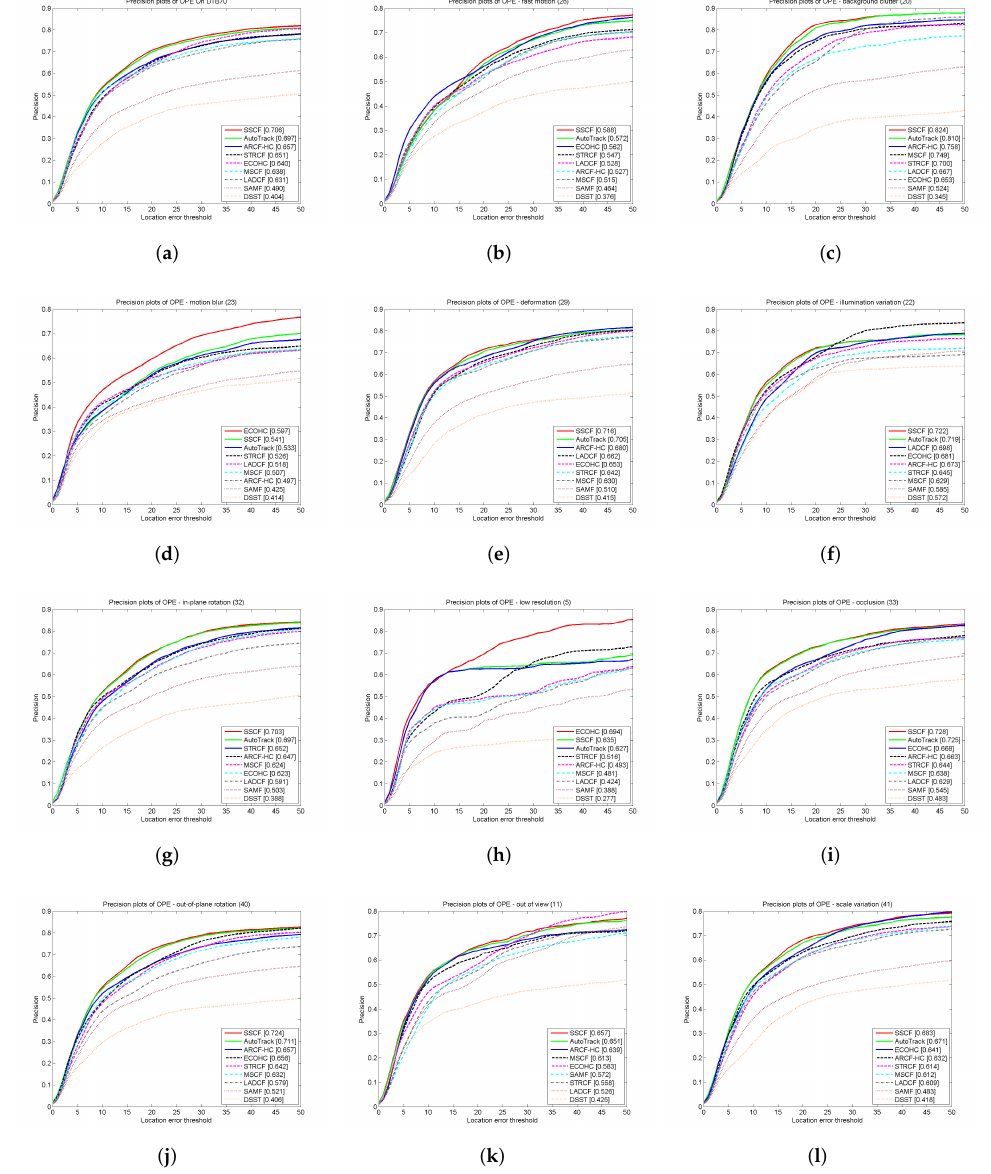
Figure 5. Precision plots of the proposed SSCF and the other trackers on the DTB70 database. ( a ) Overall performance; ( b – l ) precision plots on the 11 different